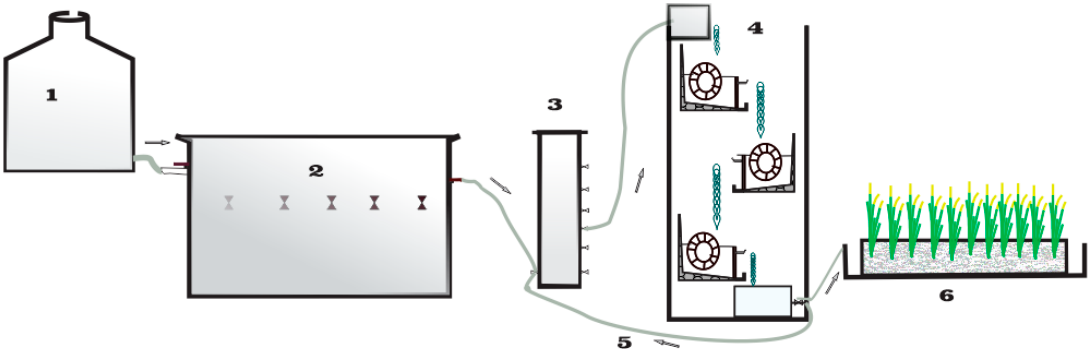
Figure 1. Schematic diagram of bio ‐ ecological system; → wastewater flow directions; 1. Storage Tank for wastewater; 2. ABR (Anaerobic Baffled Reactor, equipped with DN10 sampling port); 3. Anoxic Tank (equipped with outlets for flow from different heights); 4. Oxic Unit (consisted of three sub ‐ parts, each part consisted of a rectangular tank, a bio ‐ wheel, and a rotating disc); 5. Return flow to anoxic tank from oxic unit; 6. Horizontal Flow Constructed Wetland